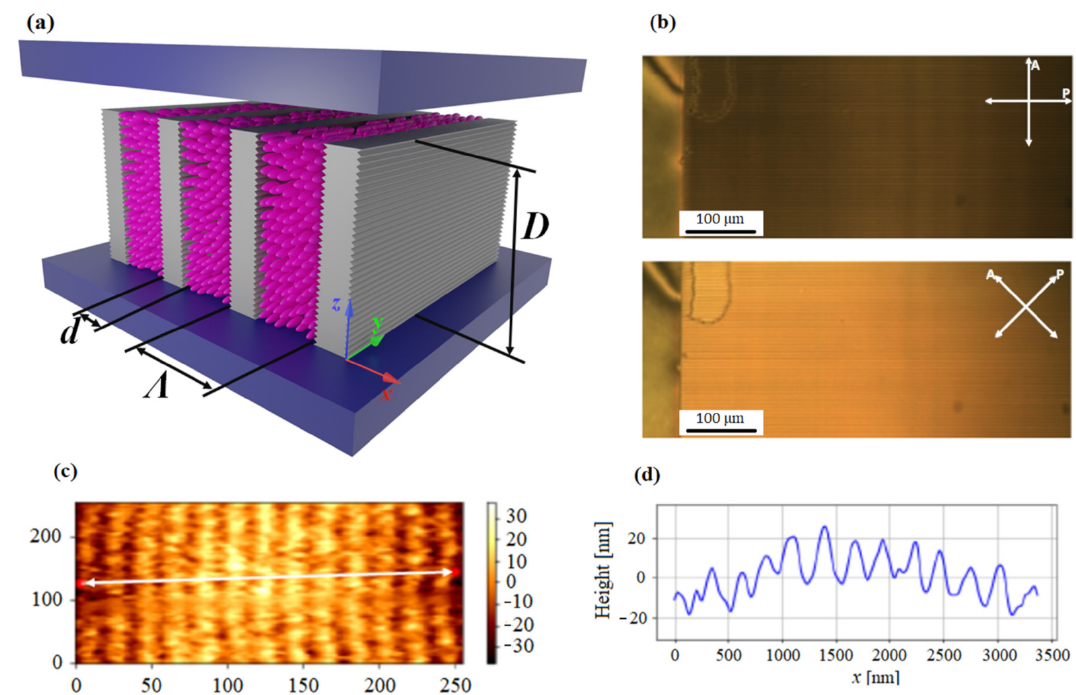
Figure 1. ( a ) Schematic drawing of the polymer scaffold filled with a nematic liquid crystal. The polymer scaffold is constructed as parallel polymeric ribbons fabricated from the photoresist polymer SU-8. Grey walls with the periodic surface relief structure indicate polymer ribbons, and pink ellipsoids indicate LC molecules. ( b ) Polarization optical microscopy (POM) image of the grating structure filled with the nematic LC material showing perfect LC alignment in the region of the grating structure and practically no alignment outside of the grating region. The images were captured under crossed polarizers rotated by 0 ◦ /90 ◦ (top image) and 45 ◦ /135 ◦ (bottom image) with respect to the grating lines. ( c ) Atomic force microscopy (AFM) image of the periodic surface relief structure at a sidewall of the ribbon. ( d ) The cross-sectional profile of the image along the white line indicated in ( c